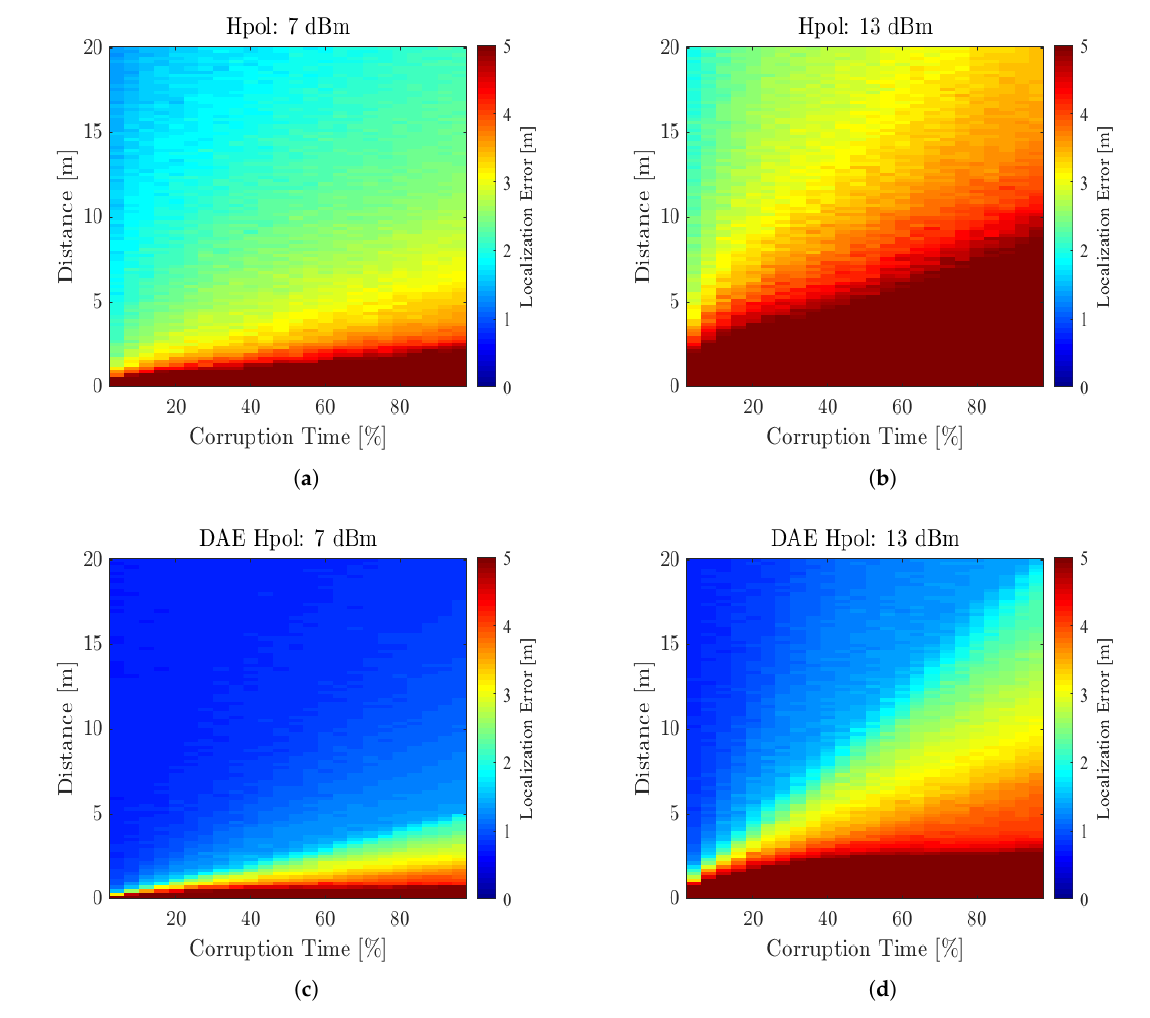
Figure 9. Error surface of the localization algorithms for increased interference distances and corruption times and the simultaneous effect on 3D CSI extraction of a horizontally polarized target emitter with interference power levels of ( a ) 7 dBm 3D CSI, ( b ) 13 dBm 3D CSI, ( c ) 7 dBm DAE 3D CSI, and ( d ) 13 dBm DAE 3D